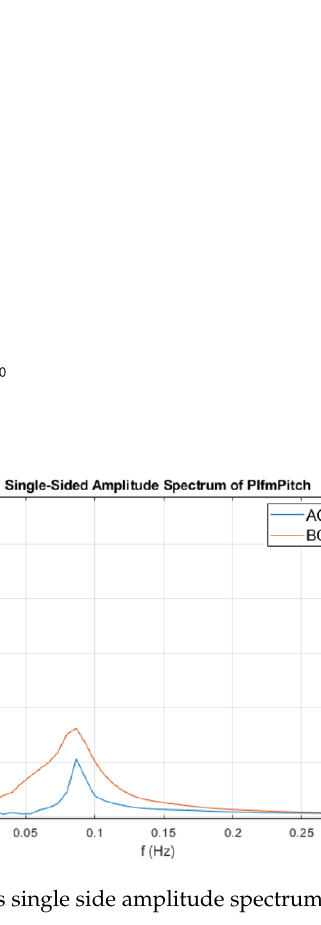
Figure 7. Platform pitch without waves ( left ) and its single side amplitude spectrum ( right ).